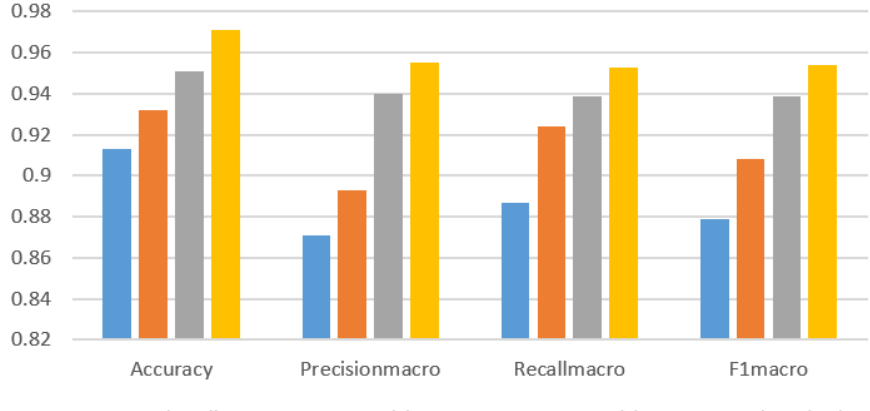
Figure 8. Comparison of the Accuracy, Precision macro , Recall macro , and F1 macro